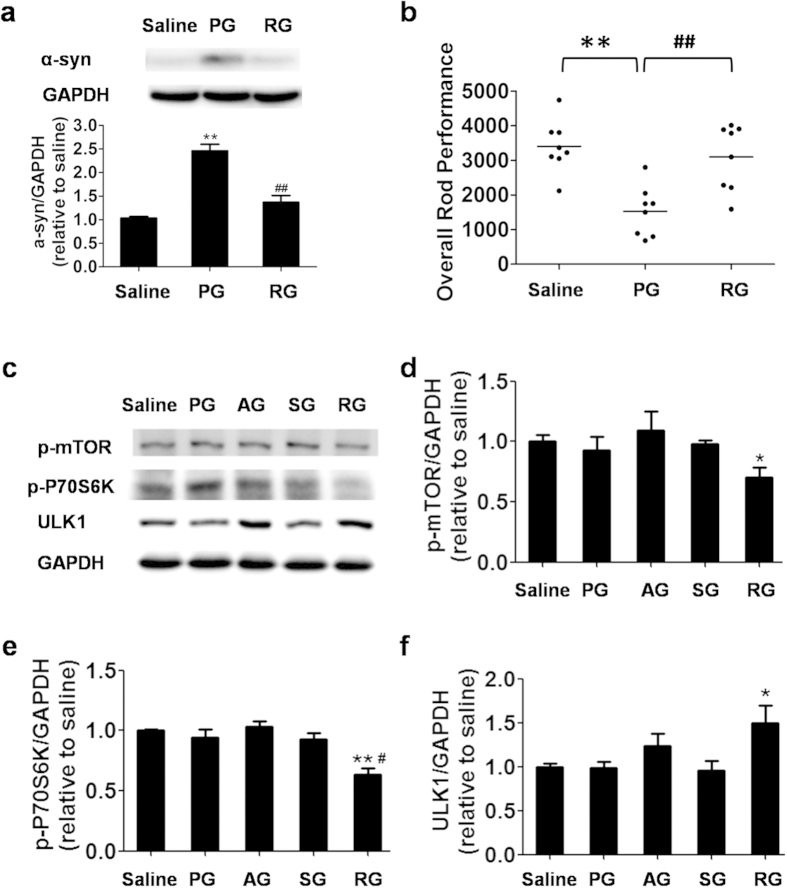
Rapamycin treatment decreases α-syn accumulation and restores the autophagy-lysosome pathway in the substantia nigra of PD mouse.(a) Immunoblot and the optical density of α-syn in the mouse SNpc in each group after rapamycin treatment for 12 days. (b) The overall rod performance (ORP) scores of mice in each group (n = 8). (c) Immunoblot levels of p-mTOR, p-P70S6K and ULK1 in the mouse SNpc in each group after acupuncture and rapamycin treatment. (d–f) The optical density of p-mTOR, p-P70S6K and ULK1 in the mouse SNpc in each group. In all panels, *P < 0.05, **P < 0.01 compared with SG. #P < 0.05, ##P < 0.01 compared with PG.